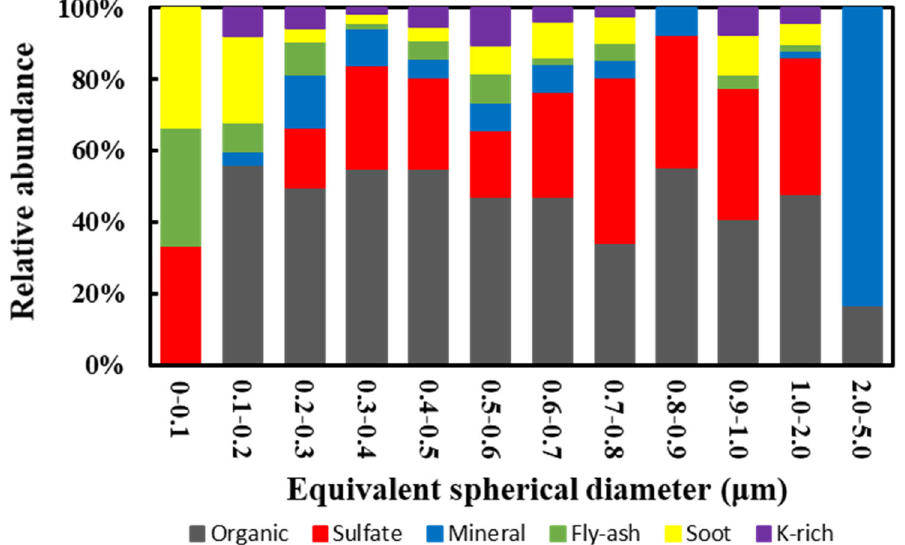
Figure 4. Relative number abundance–size distribution plots for all types of particles obtained by adding together the data for all four sampling days in the winter haze of Xi’an during the sampling period.